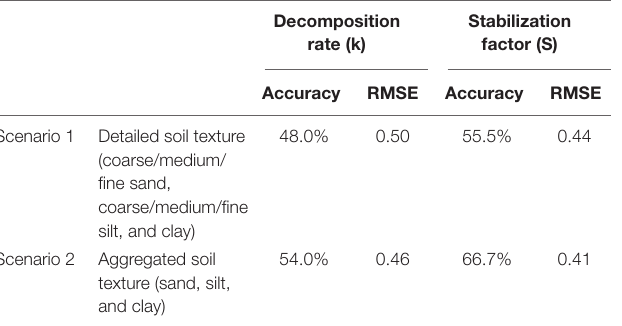
FIGURE 2 | Classification tree for predicting decomposition rate ( k ). Low represent values ( ≤ 0.0127 g d–1), medium values (0.0127–0.0210 g d–1), and high values ( > 0.0210 g d–1).